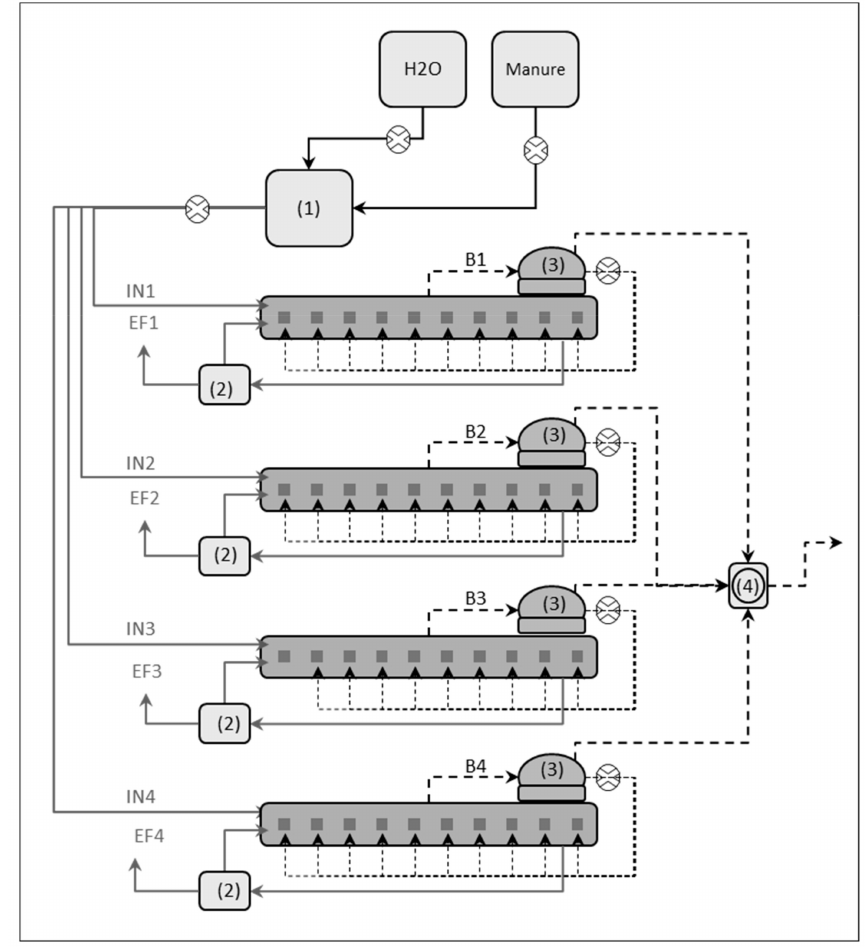
Figure 1. Scheme of the pilot plant: Numbers: ( 1 ) influent tank; ( 2 ) e ffl uent tanks; ( 3 ) gas holder; ( 4 ) biogas flow-meter. Nomenclature: IN, influent; EF, e ffl uent; B,